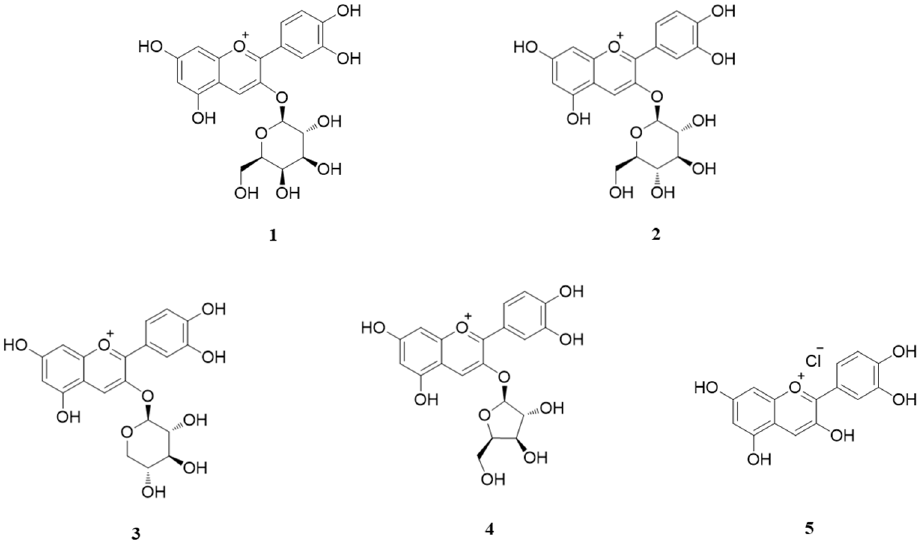
Figure 2. Chemical structures of compounds from the Aronia bioactivity fraction (ABF ® ) 1 – 5 .